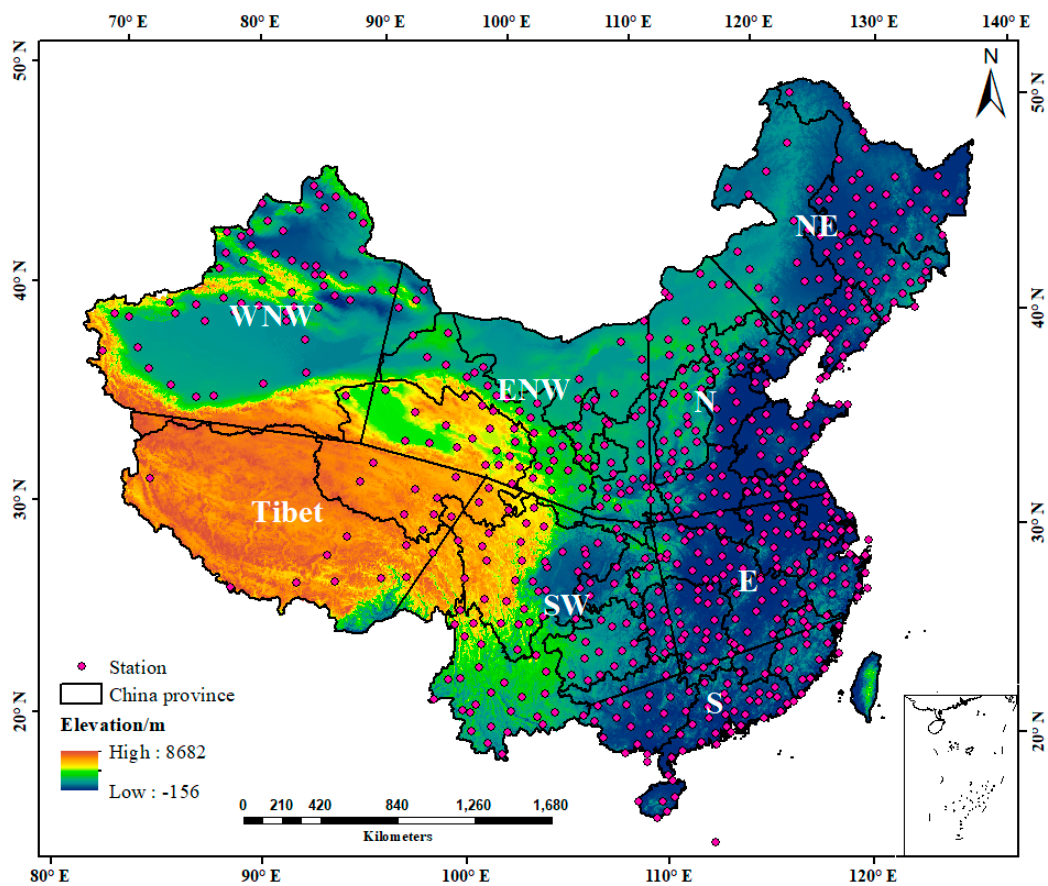
Figure 1. Locations of 655 rain-gauge stations in China. Southwest, east, and south China are marked by SW, E, and S, respectively. These three regions constitute southern China. Northeast, north, eastern northwest, and western northwest China are marked by NE, N, ENW, and WNW, respectively. These regions constitute northern China. The Tibetan Plateau is marked as Tibet.